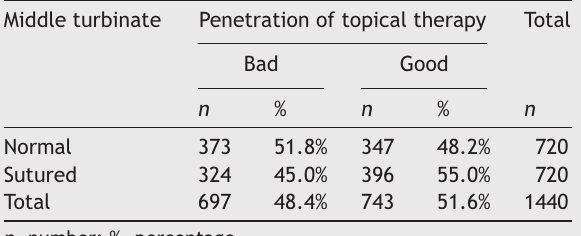
Penetration of topical therapy according to the middle turbinate.